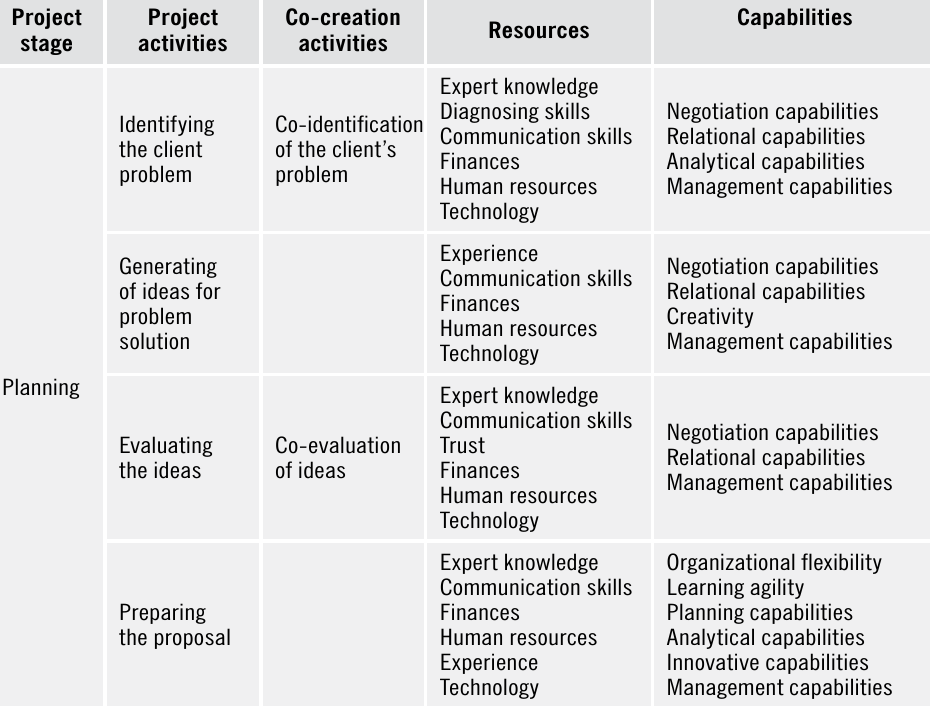
Table 8. Resources and capabilities employed to value co-creation in engineering service innovation